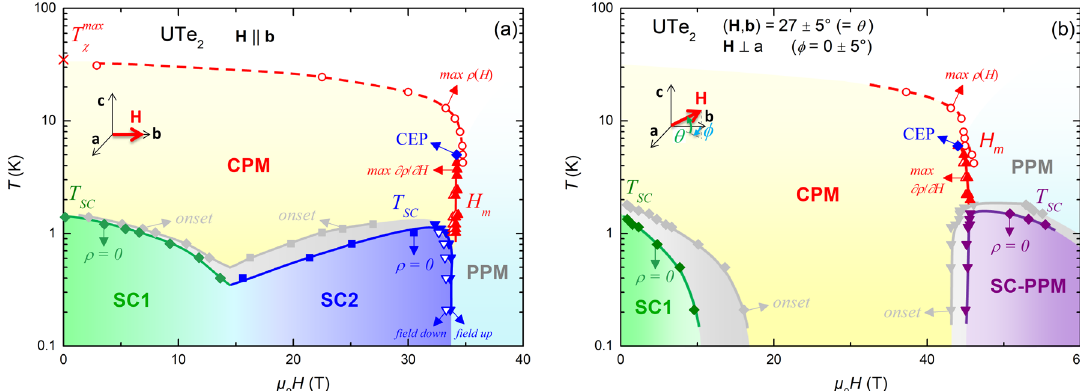
Fig. 3 Magnetic phase diagrams of UTe 2 . a Magnetic- fi eld-temperature phase diagram of UTe 2 in a magnetic fi eld H || b . b Magnetic- fi eld-temperature phase diagram of UTe 2 in a magnetic fi eld H tilted by 27 ± 5° from b in the ( b , c ) plane. Two low-temperature paramagnetic regimes and identi fi ed: correlated paramagnetism (CPM) and polarized paramagnetism (PPM). SC1 is the low- fi eld superconducting phase, and SC2 and SC-PPM are the superconducting phases induced by magnetic fi elds H || b and H tilted by 27 ± 5° from b in the ( b , c ) plane, respectively. T SC is the critical superconducting temperature, T χ max is the temperature at the maximum of the magnetic susceptibility, and H m is the metamagnetic fi eld. For the superconducting phases, colored points indicate the temperature at which zero-resistivity is reached and gray points indicate the temperature at the onset of the downwards deviation of the resistivity. CEP indicates the critical end-point of the fi rst-order metamagnetic transition.